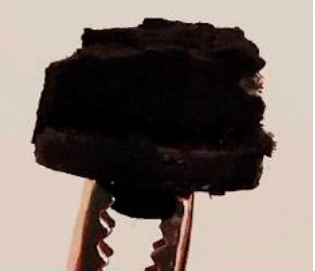
Figure 3. Manufactured soft carbon electrode.